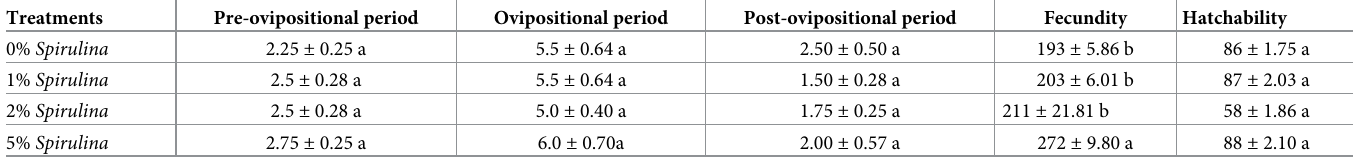
Means followed by the same letters within each column do not differ significantly ( P < 0.05).